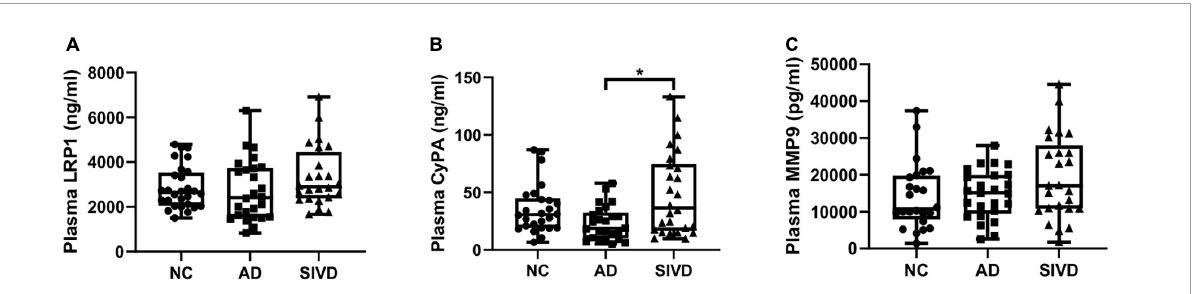
using the receiver operating characteristic (ROC) curve. p < 0.05 was considered to indicate significant results. p -values were corrected using the Bonferroni method for multiple comparison corrections. All statistical analyses were performed using SPSS version 23.0 (SPSS Inc., Chicago, IL, United